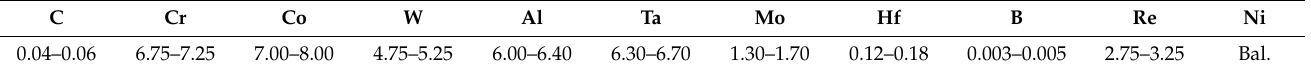
Table 1. DD5 single crystal blade design composition (wt/%).